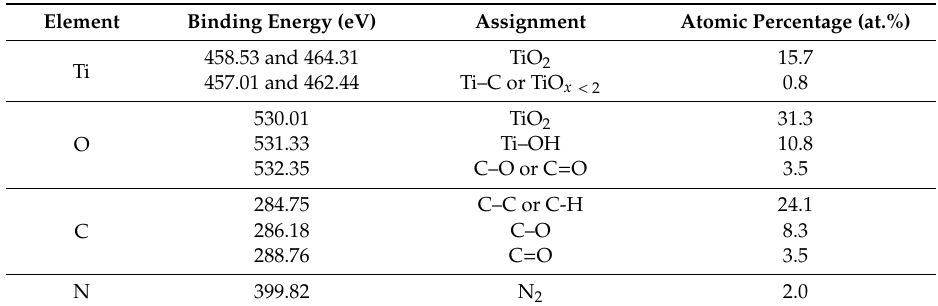
Table 1. Surface elements chemical state, peak position and atomic percentage from X-ray photoelectron spectroscopy (XPS)